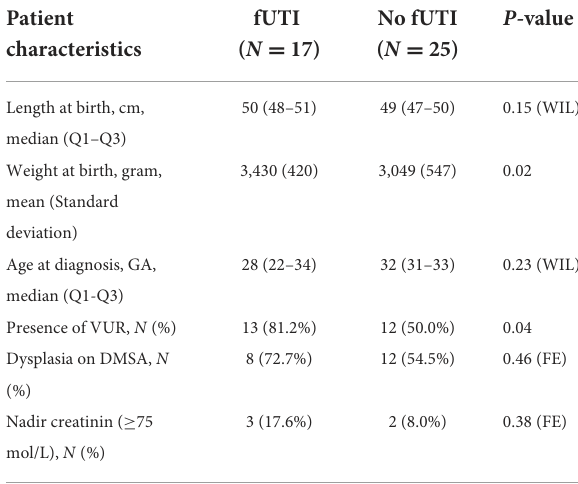
TABLE 2 Patient characteristics according to presence or absence of fUTI.